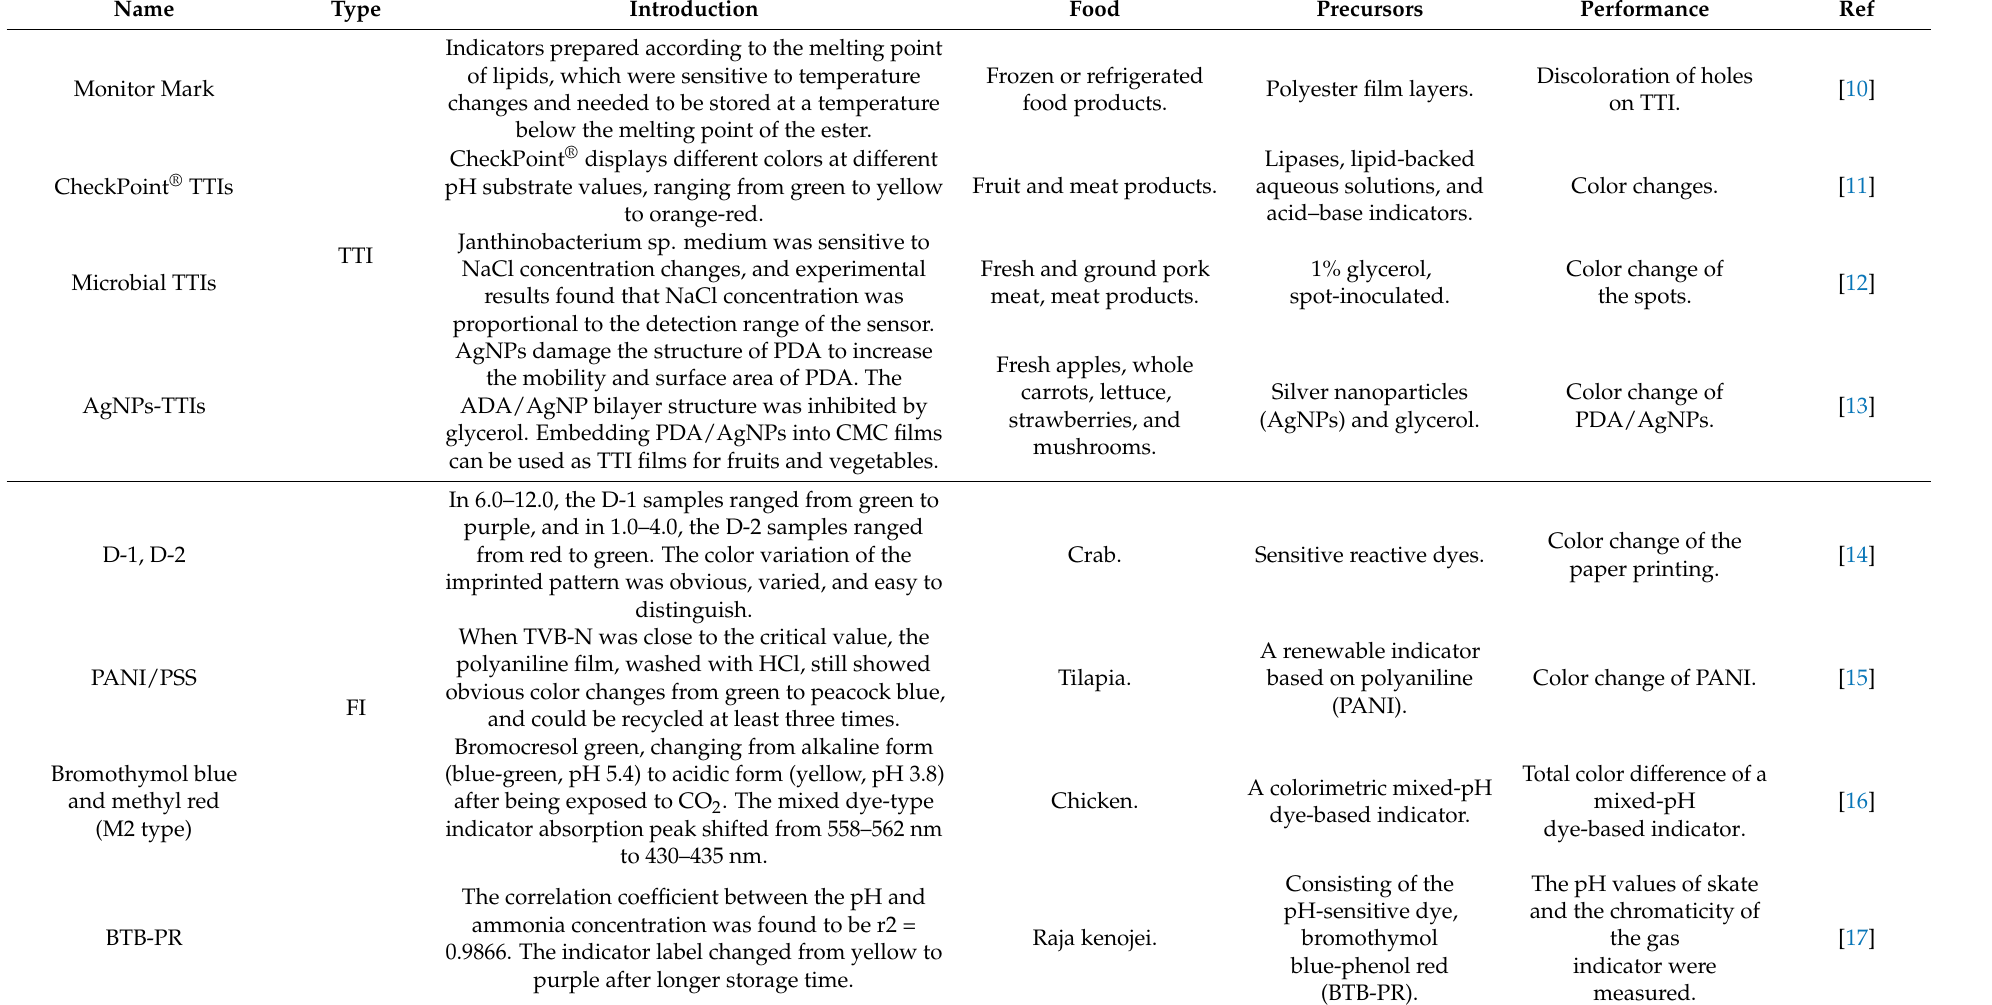
Table 1. Classification and application of indicators in food